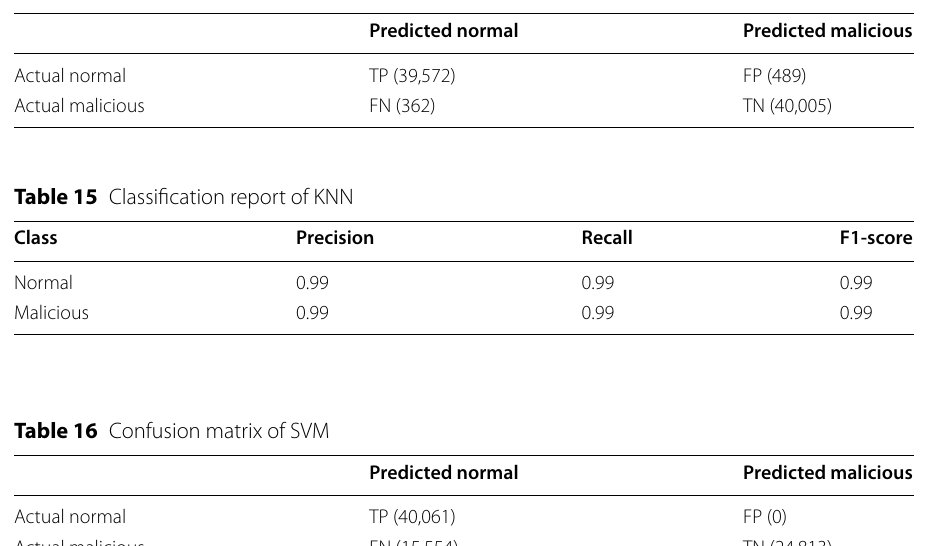
Table 14 Confusion Matrix of